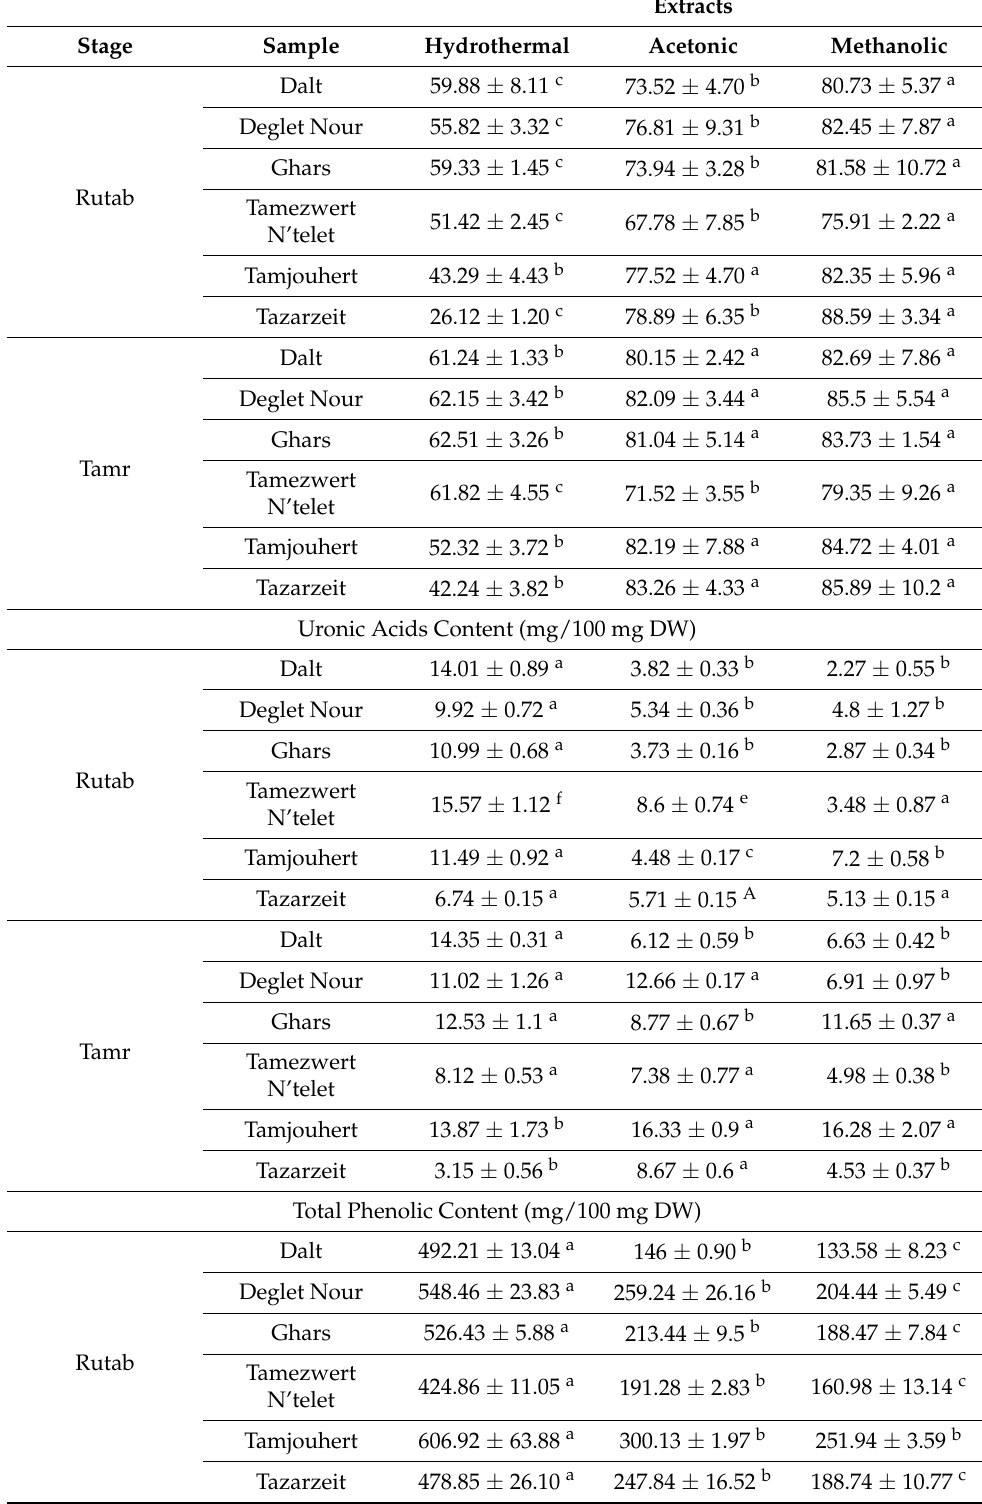
Table 1. Total sugar and uronic acid content in all varieties and stages for the three extraction